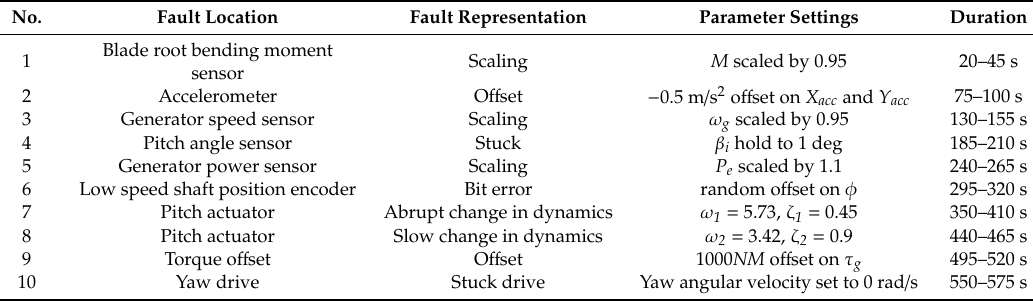
Table 3. The instructions of fault generation.